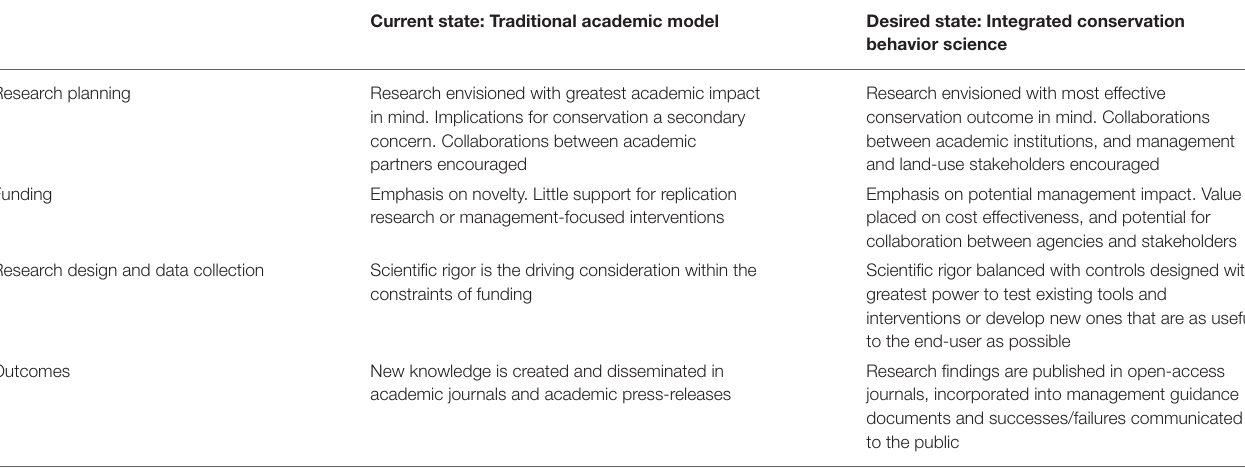
TABLE 1 | Case studies of current and desired state of applied conservation behavior